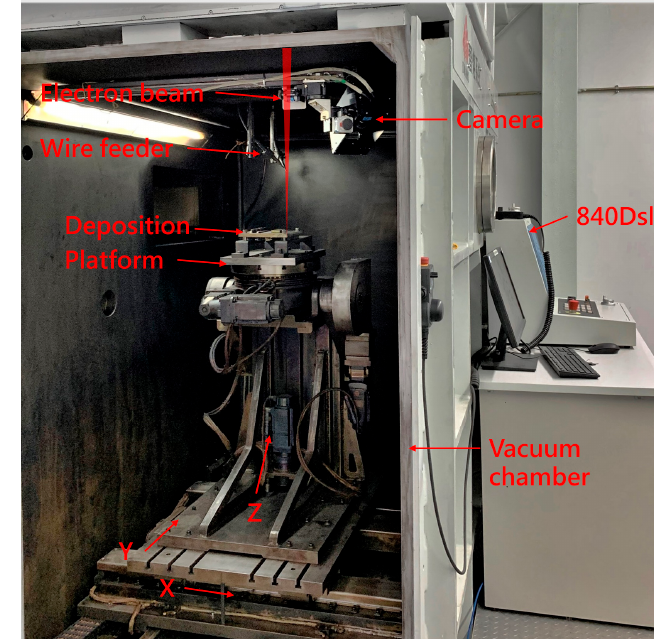
Figure 14. Configuration of the online measurement system.